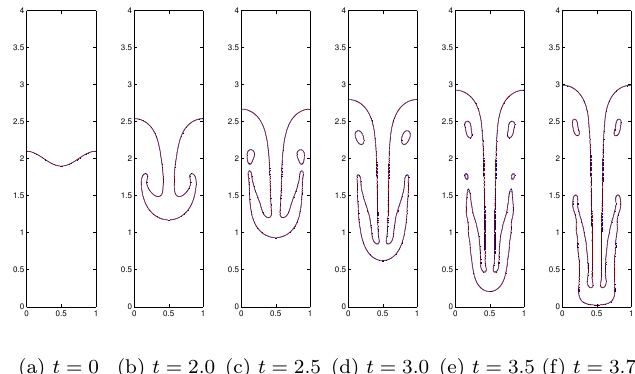
Figure 2. The interface of Problem 2 for Re = 1000 and At = 0 .